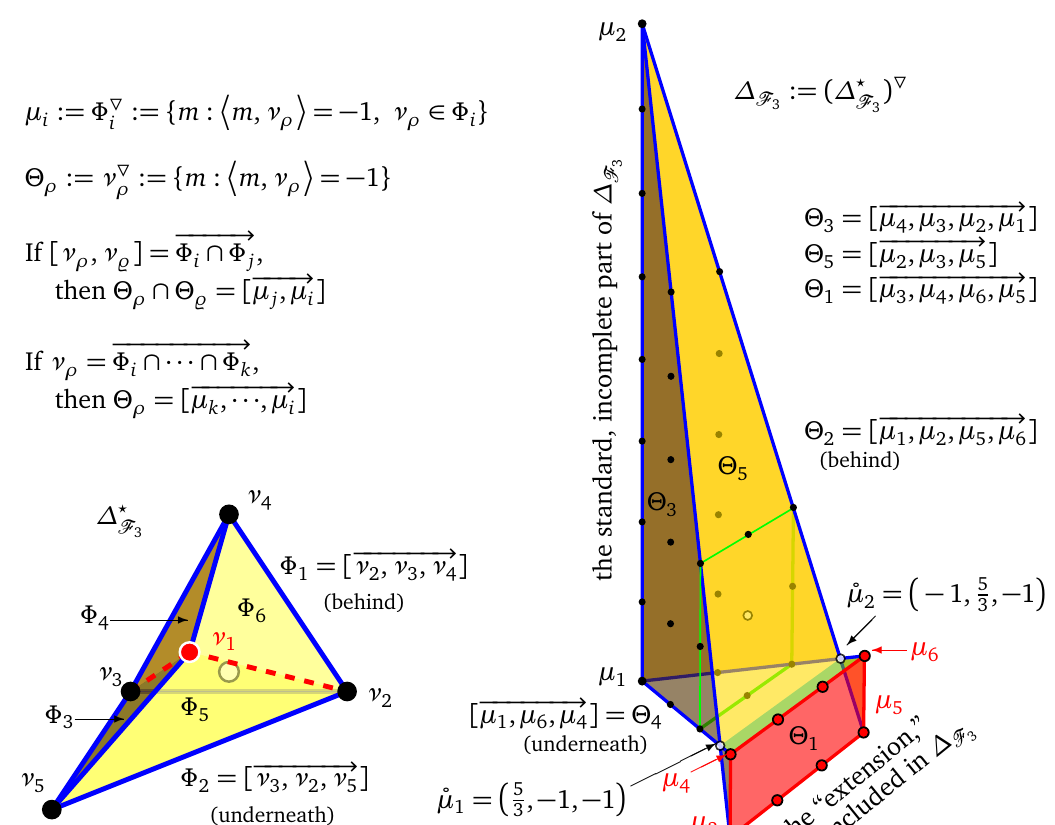
Figure 3: The spanning polytope ∆ (cid:63) elements indicated. The outward orientation of ∆ (cid:63) Φ ∩···∩ Φ , and so induces the ( reverse ) ordering of Φ (cid:207) i k